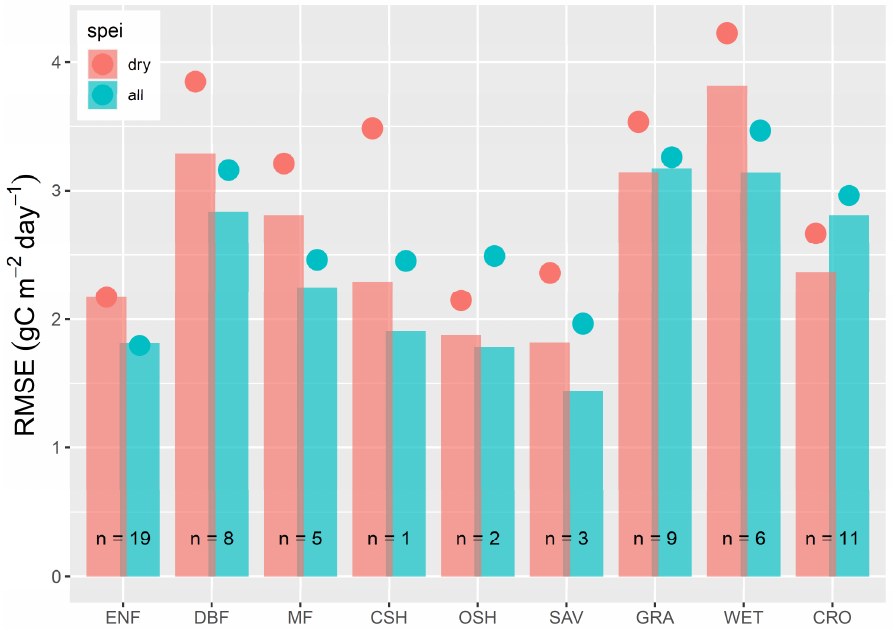
Figure 3. Error estimation (GPP simulations versus eddy-covariance) by vegetation class with the number of participating sites indicated. Those periods identified as unusually dry (SPEI < −1.5) are shown in red and contrasted with the full timeseries (all, in blue). Bars relate to simulations driven by S3_LST and dots to ECMWF gridded T air .